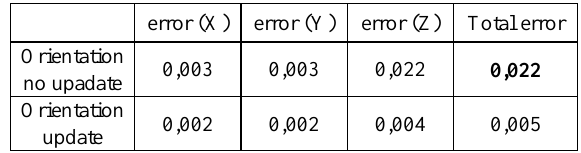
Table 1. Synthesis of the orientation residual before and after